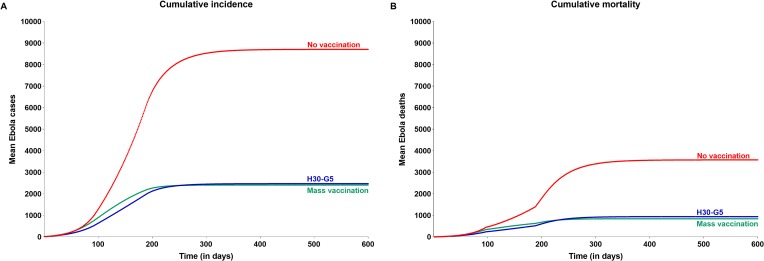
Impact of reactive mass vaccination on cumulative incidence and mortality associated with Ebola virus disease, compared with H30-G5 prophylactic vaccination strategy.Vaccine profile assumed for mass vaccination: Time to onset of protection: 7 days, duration of protection: 180 days, efficacy: 100%. Daily rate at which vaccination is carried out: 0.1% (general population) and 5% (HCW). Abbreviations: HCW, health care worker; H30-G5, vaccination of 30% of all HCW plus 5% of the general population.